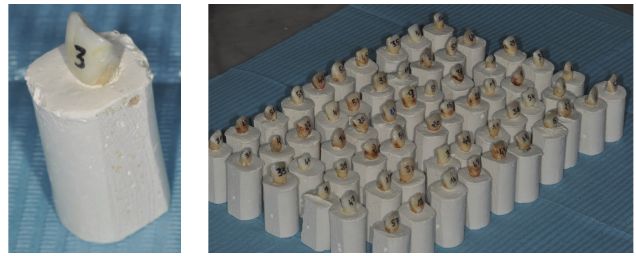
Figure 1: Samples with plinth base.